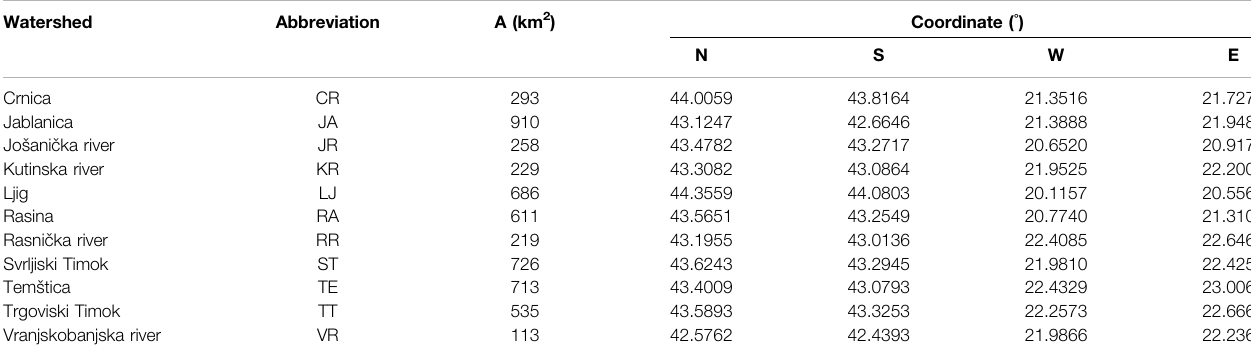
TABLE 1 | Geographical position of 11 mountains watersheds ranked in alphabetical order.